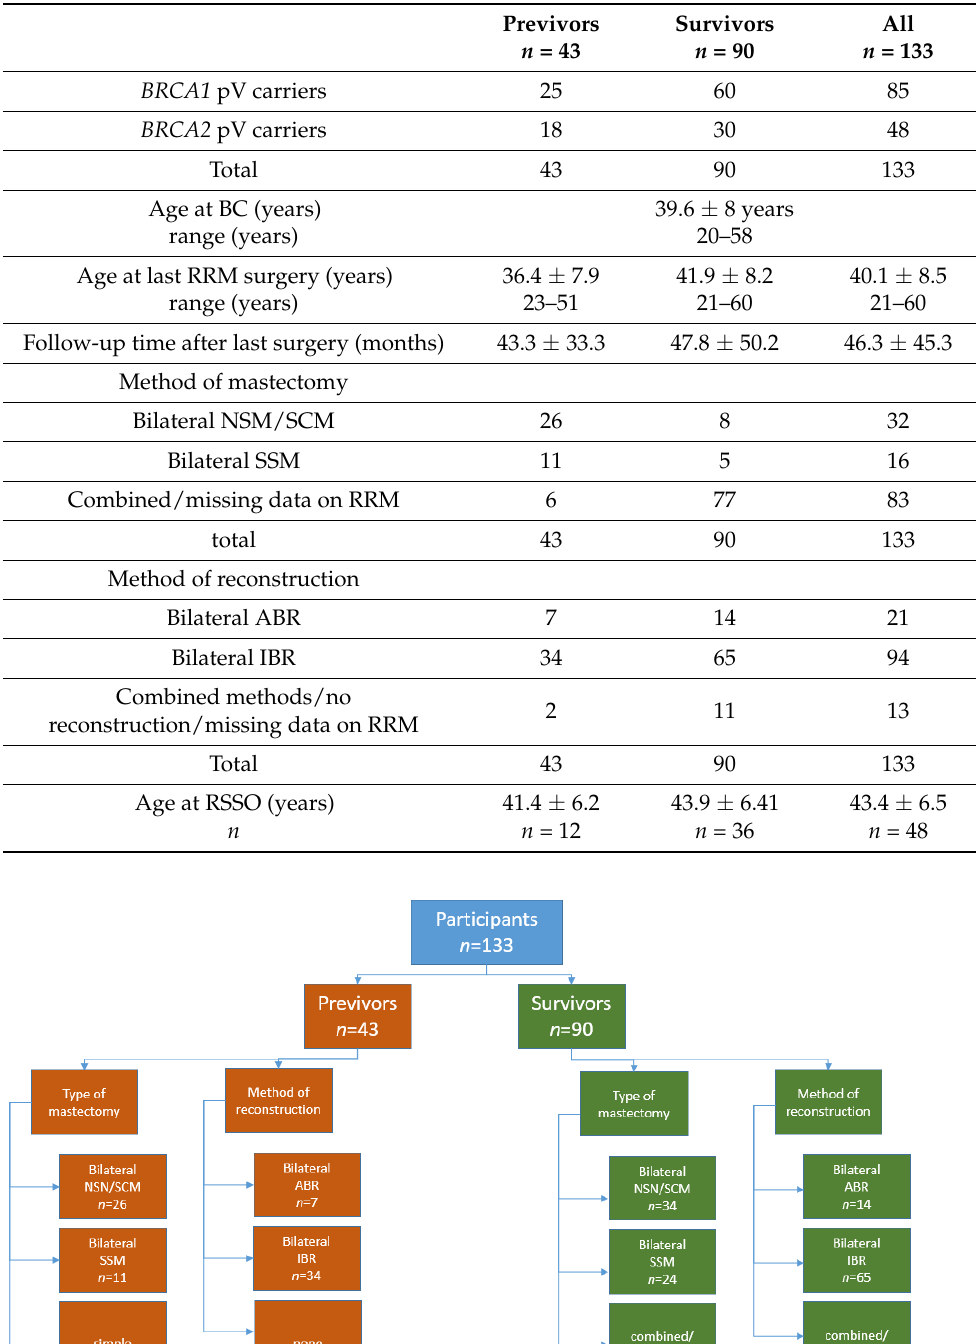
Table 1. Participants’ characteristics. Values are presented as mean ± SD. Carriers of pV Class 4 and 5 were included. Class 4: Probability of pathogenicity 0.95–0.99; Class 5: Probability of pathogenicity >0.99. Legend: ABR: autologous ‐ based breast reconstruction, IBR: implant ‐ based breast reconstruction, n = number, NSM/SCM nipple sparing/ subcutaneous mastectomy, SSM: skin ‐ sparing mastectomy.